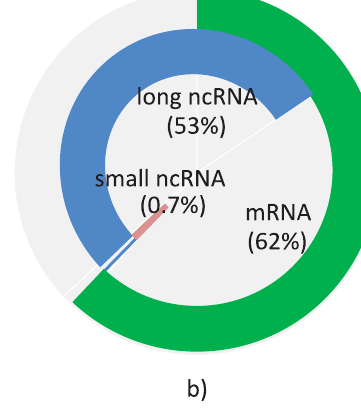
Figure 1. Composition of the human transcriptome. ( a ) Venn diagram of the number of loci containing mRNA transcripts (green), long ncRNAs (blue), and small ncRNAs (red); ( b ) Base pair coverage of the transcriptome by the three categories of